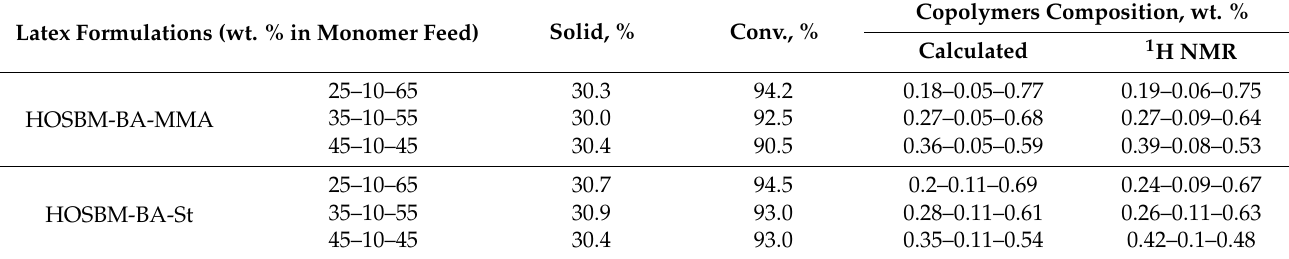
Table 1. Solid content, conversion, and composition of terpolymer latexes. Latex Formulations (wt. % in Monomer Feed) Solid, % Conv., %